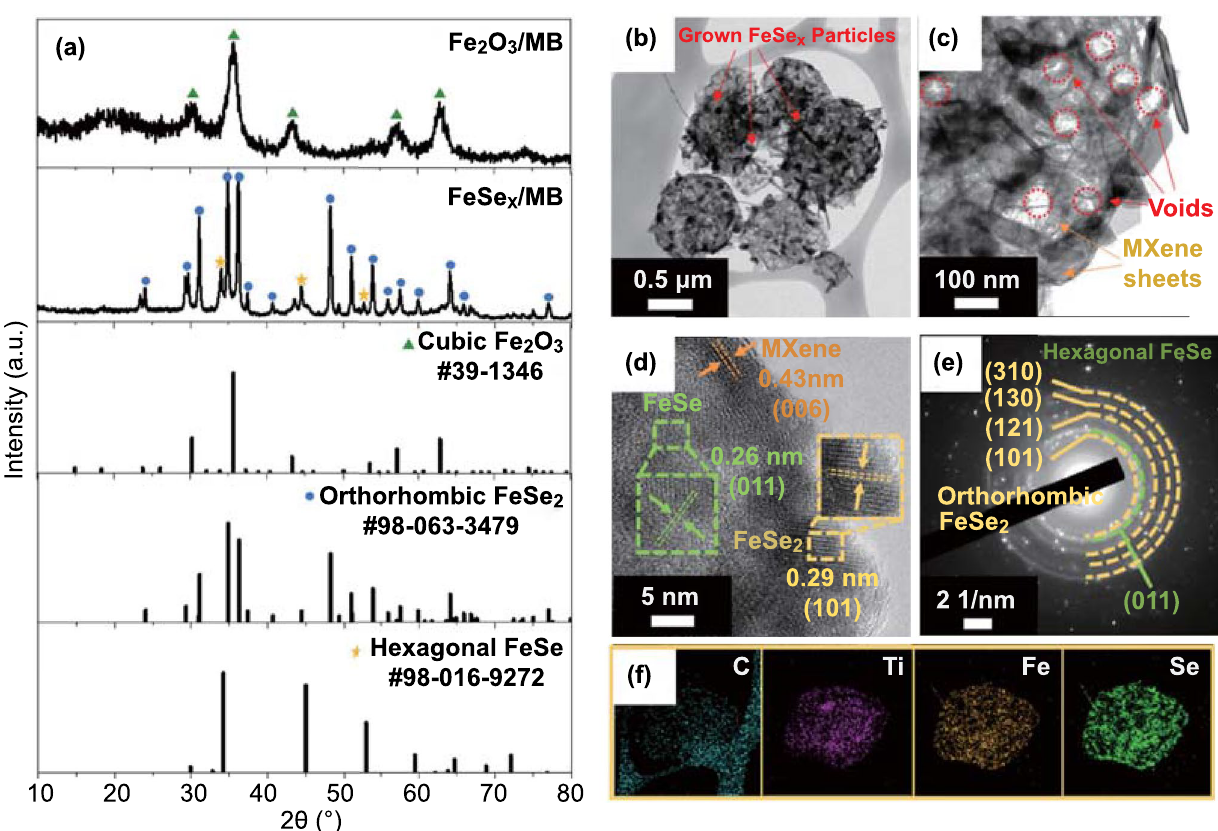
Fig. 3 a XRD patterns of Fe 2 O 3 /MB and FeSe x /MB, b, c TEM images, d HR‑TEM image, e SAED pattern, and f elemental mapping images of FeSe